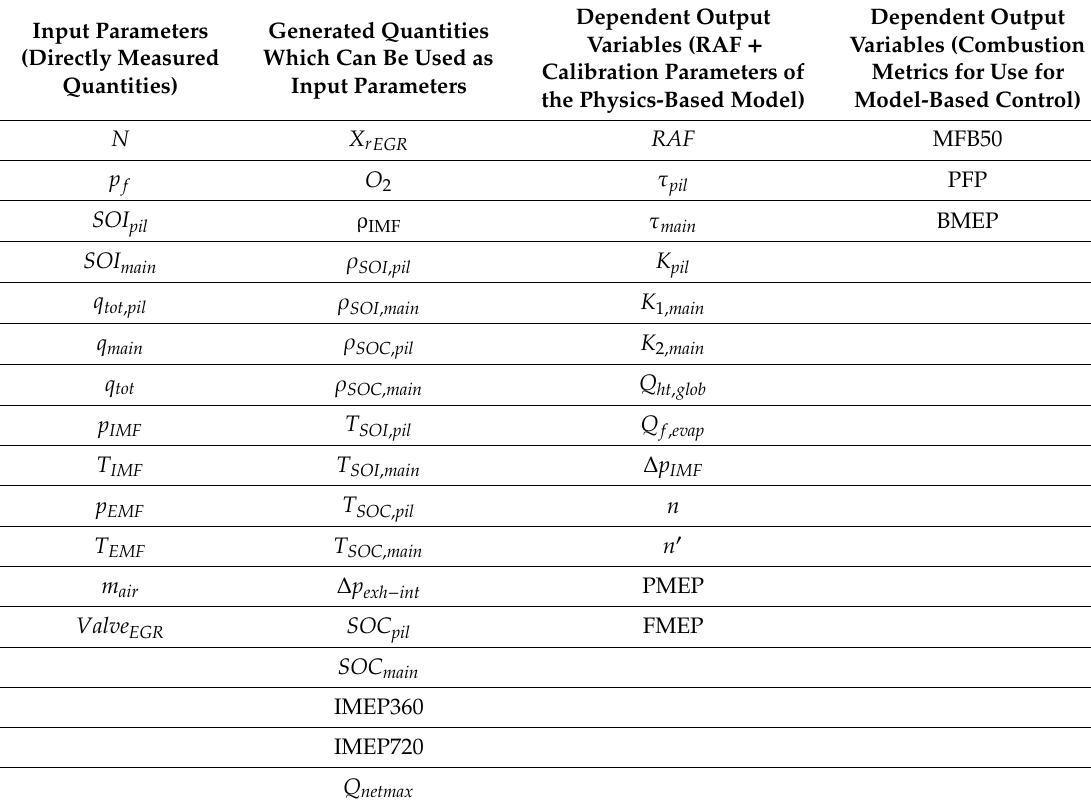
Table 3. List of the input and dependent